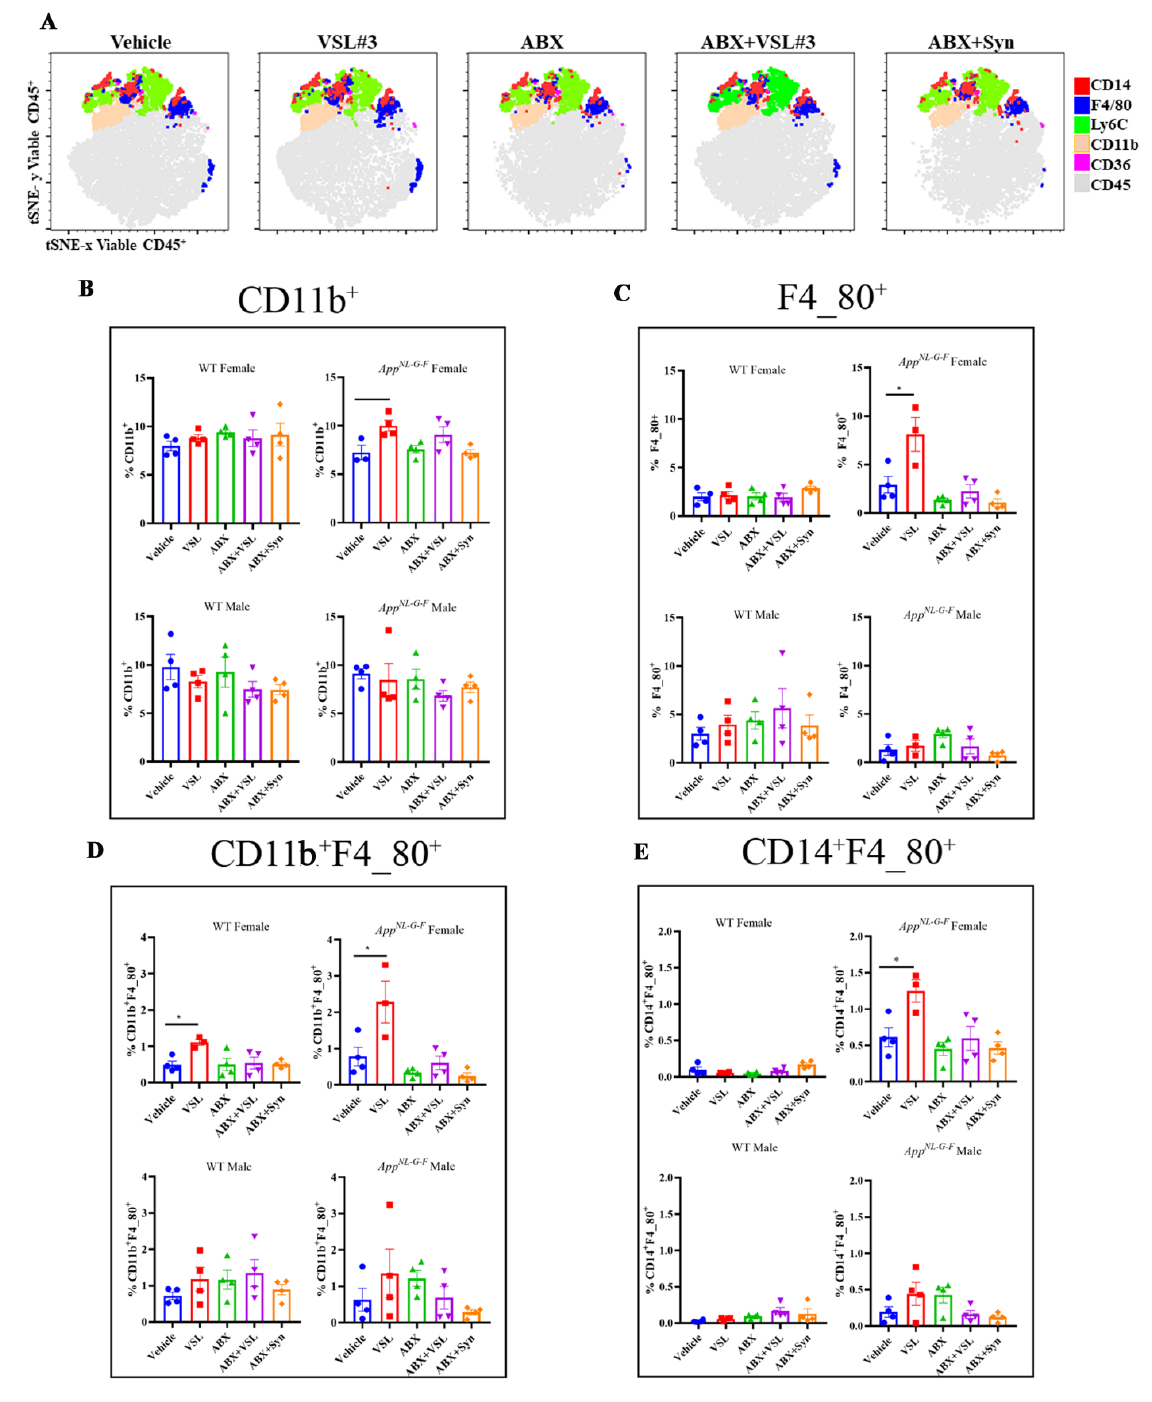
Figure 9. Upregulation of CD11b + , F4_80 + , CD11b + F4_80 + , and CD14 + F4_80 + macrophages in VSL#3-treated female App NL-G-F mice. Splenocytes were stained with a panel of cell surface markers and measured by flow cytometry. tSNE analysis was run on 4960–5000 live CD45 + single cells per sample using all surface markers, and manually gated populations were overlaid to visualize the subsets. ( A ) The data presented are representative tSNE plots for female App NL-G-F mice, generated by concatenating individual samples in each treatment group with the following parameters: iterations: 5000 and perplexity: 30. ( B – E ) Bar graphs show the mean ± SEM of the percentage of CD11b + , F4_80 + , CD11b + F4_80 + , and CD14 + F4_80 + cells across different treatment groups in female and male C57BL/6 (WT) and App NL-G-F mice ( n = 3–4 mice/group). Statistically significant differences were computed by a one-way ANOVA, * p < 0.05, ** p < 0.005.